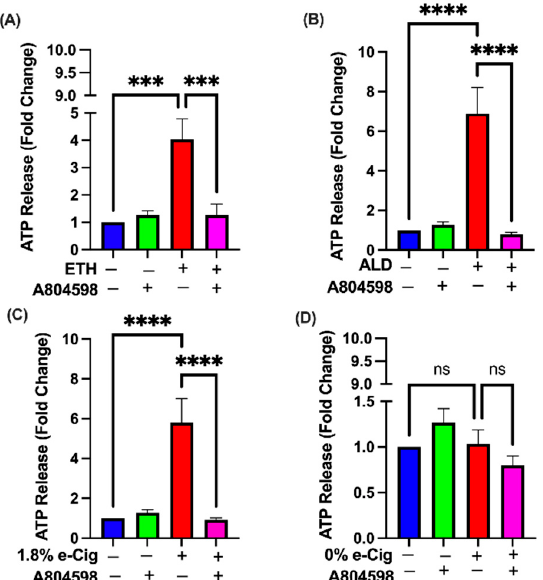
Figure 7. extracellular ATP release stimulated by ETH, ALD, and 1.8 % e-Cig exposure in hBMVECs and A804598 blocked the eATP release. hBMVECs exposed to ( A ) ETH presented a four-fold increase in eATP levels. Both ( B ) ALD and ( C ) 1.8% e- Cig demonstrated eight-fold in- creases in eATP, whereas ( D ) e-Cig with 0% nicotine showed no impact on eATP levels. Blockage of purinergic receptor (P2X7r) and TRPV1 ion channels by A804598 reduced the eATP levels ( n = 3). One-way ANOVA was used for statistical data, where *** p ≤ 0.001, **** p ≤ 0.0001 and ns (non-